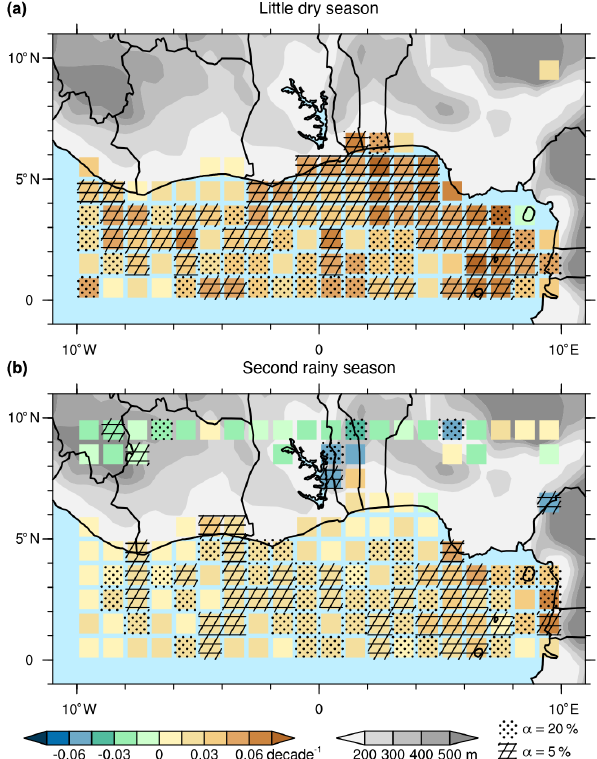
Figure 7. Aerosol trends. (a–b) Trends in MODIS aerosol optical depth (AOD) from 2002–2018 calculated from the mean values of Aqua and Terra monthly AOD for the LDS (a) and the SRS (b) . Only pixels with a sufficiently complete record are displayed here (see Sect. 2.3 for further details). Statistically significant trends are marked with dotted ( α = 20%) and hatched ( α = 5%) pixels, re- spectively.